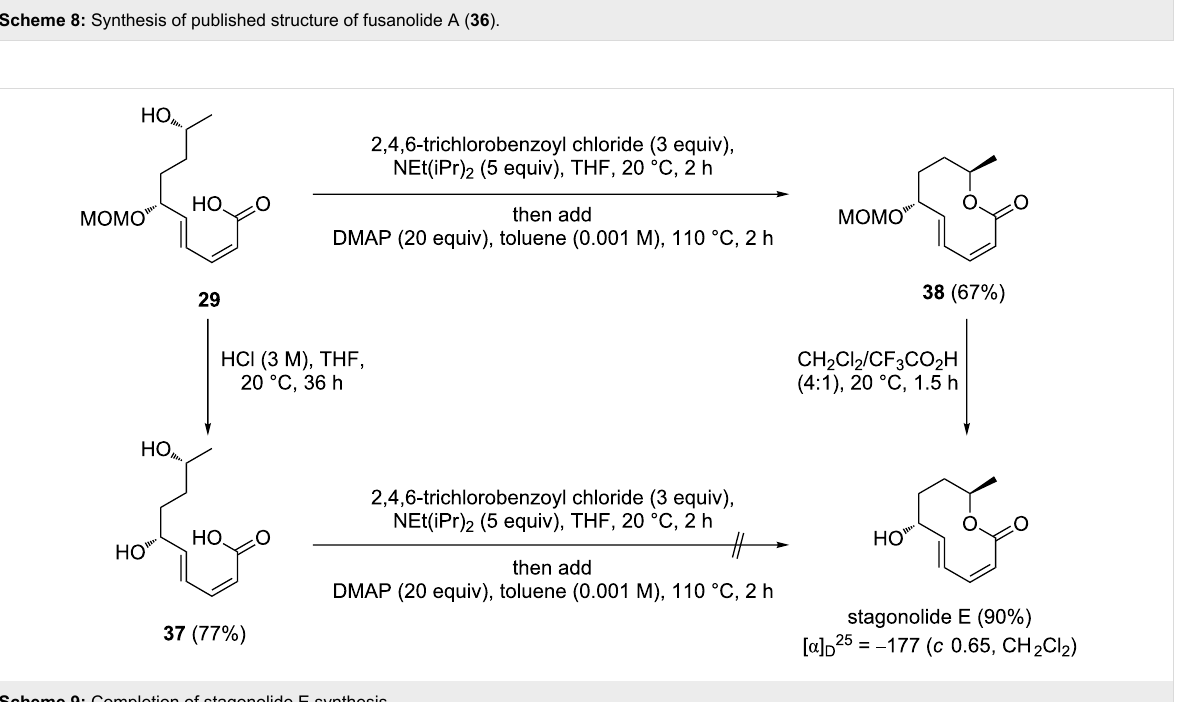
Scheme 9: Completion of stagonolide E